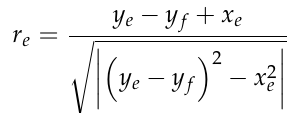
Figure 4. A coupled flow model between the whole elliptical reservoir and the primary fracture. Region III is viewed as an oval with the minor axis semidiameter of x e and the major axis semidiameter of y e − y f (The minor axis semidiameter and major axis semidiameter is determined by the specific value of corresponding parameters). We obtained the half-focal length of the oval after calculating, and the expression is Since the elliptical seepage field increases the difficulty in solving the mathematical model, the flow in an elliptical plane can be equivalent to the flow in a circular region with the seepage radius of r through conformal transformation. The expression of equivalent seepage radius r e in the circular seepage area can be written as